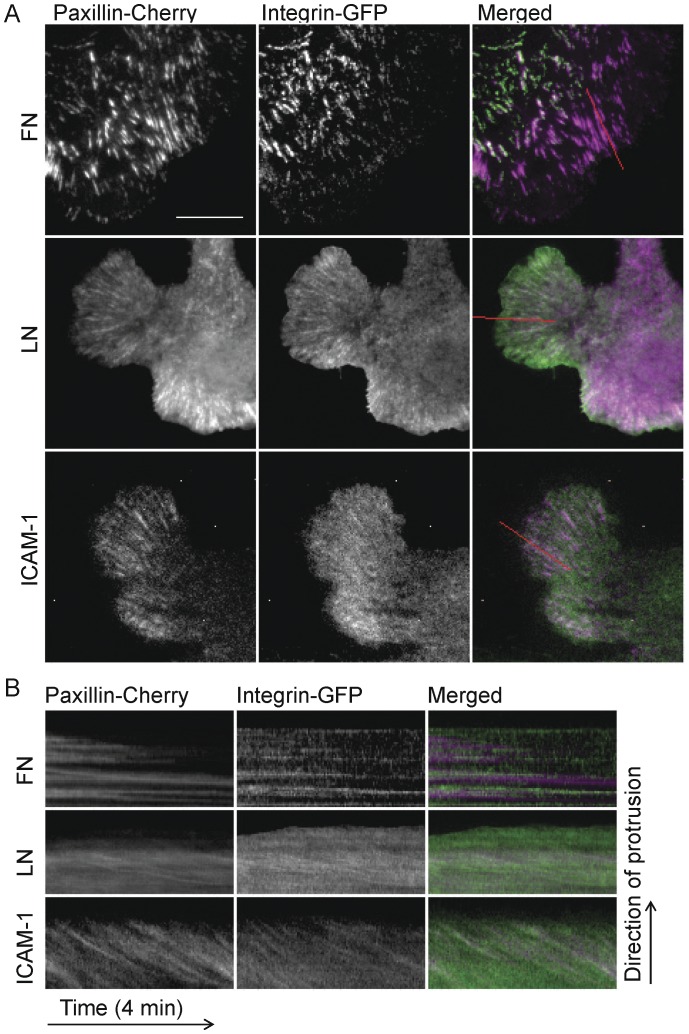
CHO.B2 cells expressing different integrins show differences in protrusion and adhesion.(A) CHO B2 cells were co-transfected with paxillin-mCherry and α5-GFP, α6-GFP or αL-GFP + β2-GFP and then plated on FN, LN or ICAM-1. In the merged color panels, paxillin is in magenta and integrins are in green. Scale Bar  = 10 µm. (B) Kymographs of cell edge and adhesions in protrusions. The retrograde fluxing of the integrins and paxillin on LN or ICAM-1 are revealed by the movement of discrete molecular units within the adhesion; this is apparent in the downward parallel line formed in the kymographs that overlie adhesions: paxillin (left), integrin (center) and merged (right). Note that the entire adhesion remains largely in place during the fluxing on LN; this also occurs on ICAM-1.